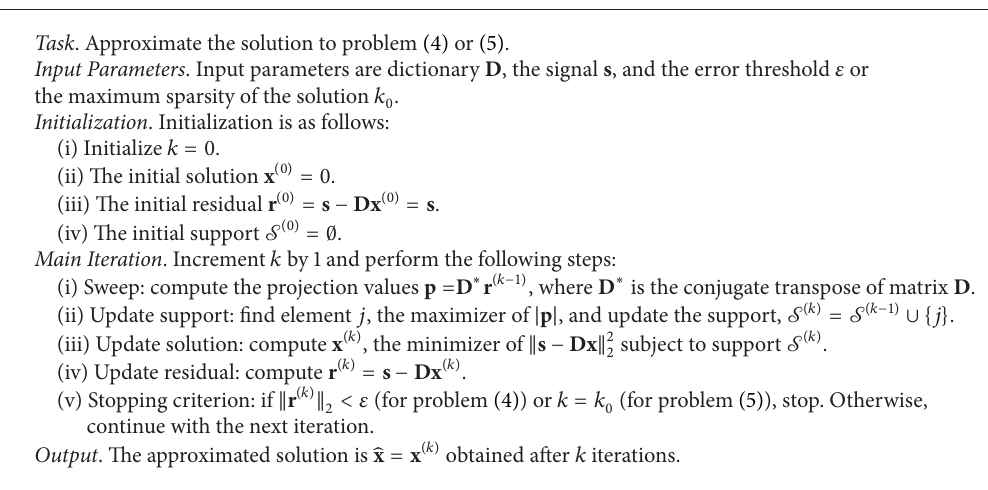
Algorithm 1: Orthogonal Matching